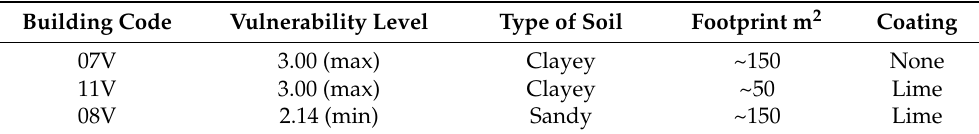
Table 9. Comparison of characteristics affecting the vulnerability of vernacular earthen architecture.